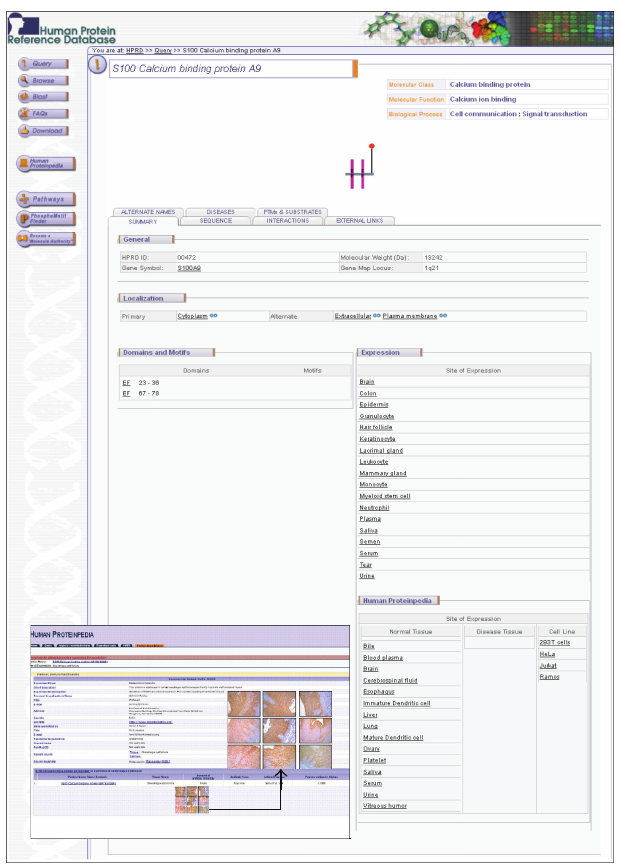
Figure 5: A snapshot of S100 calcium binding protein A9 annotation in Human Protein Reference Database (HPRD) and Human Proteinpedia. The molecule page of S100A9 in HPRD is shown. Also shown in the figure is the immunohistochemical labeling data for S100A9 from Human Proteinpedia, a public portal that provides data for a given protein from different experimental platforms. The figure shows the immunohistochemical staining of S100A9 in selected normal esophageal epithelial